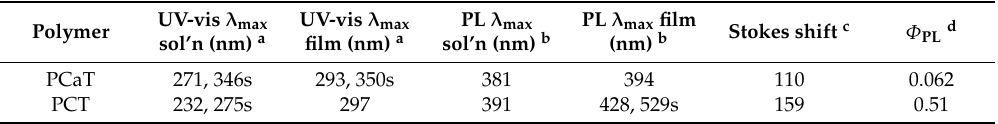
Table 2. Optical properties of polymers.